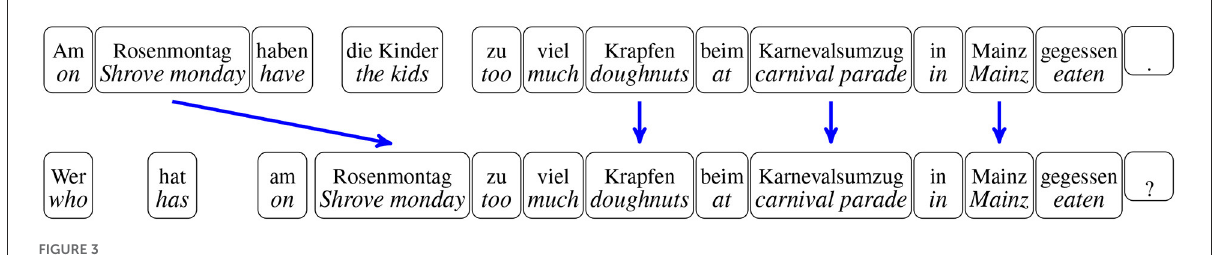
FIGURE3 Example illustrating minimal identification of rare words and named entities in support of